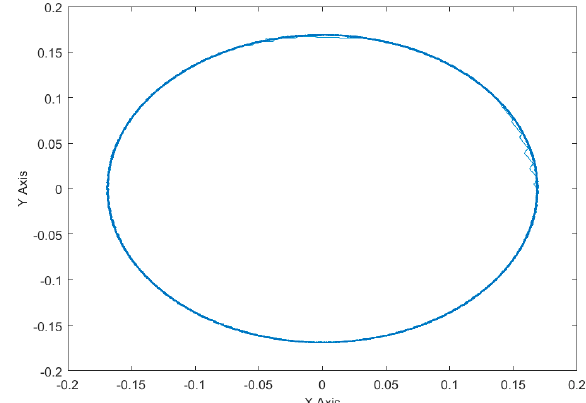
Figure 12. The TDRBF-NSMC control flux trajectory.